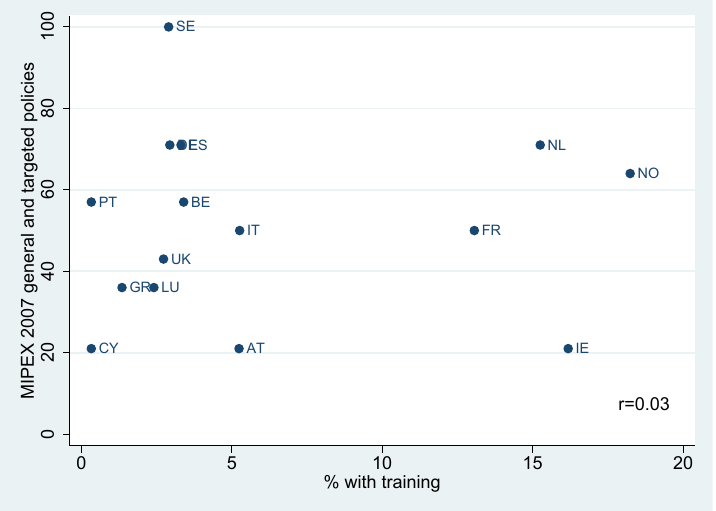
Figure 2: Proportion of immigrants who participated in training and countries’ MIPEX of labor market mobility, access to general and targeted